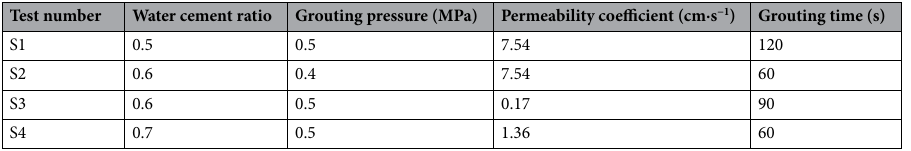
Table 3. Test design